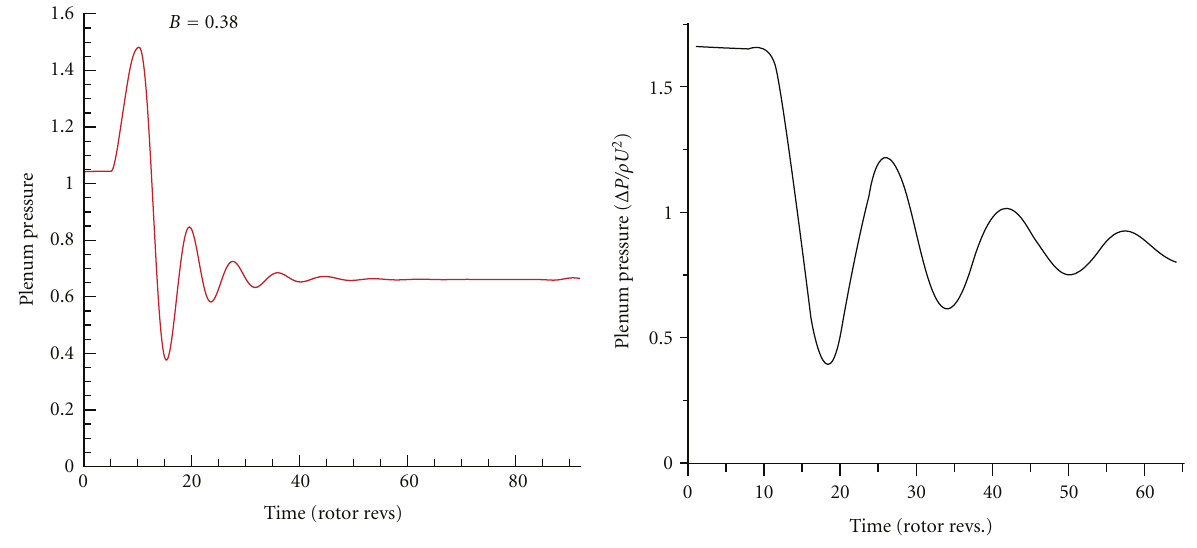
Figure 4: Numerical and experimental plenum pressure coe ffi cients during rotating stall [2].